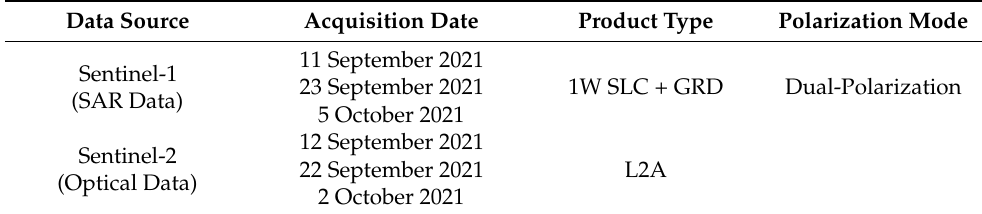
Table 1. Remote sensing data